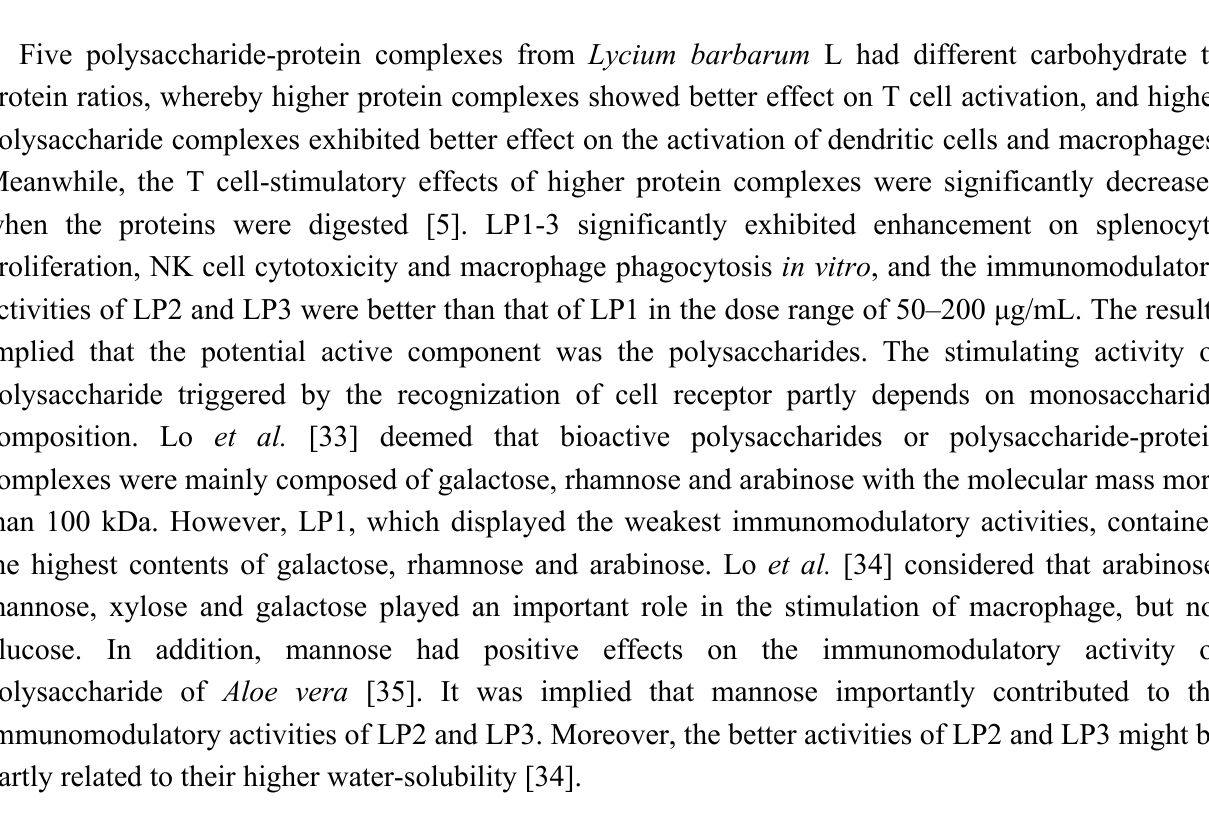
Five polysaccharide-protein complexes from Lycium barbarum L had different carbohydrate to protein ratios, whereby higher protein complexes showed better effect on T cell activation, and